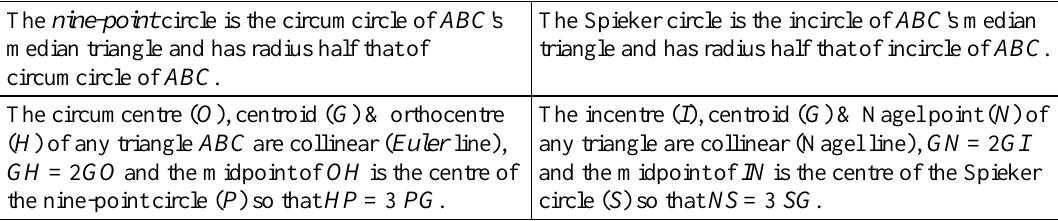
Figure 4: Nine-point & Spieker circles